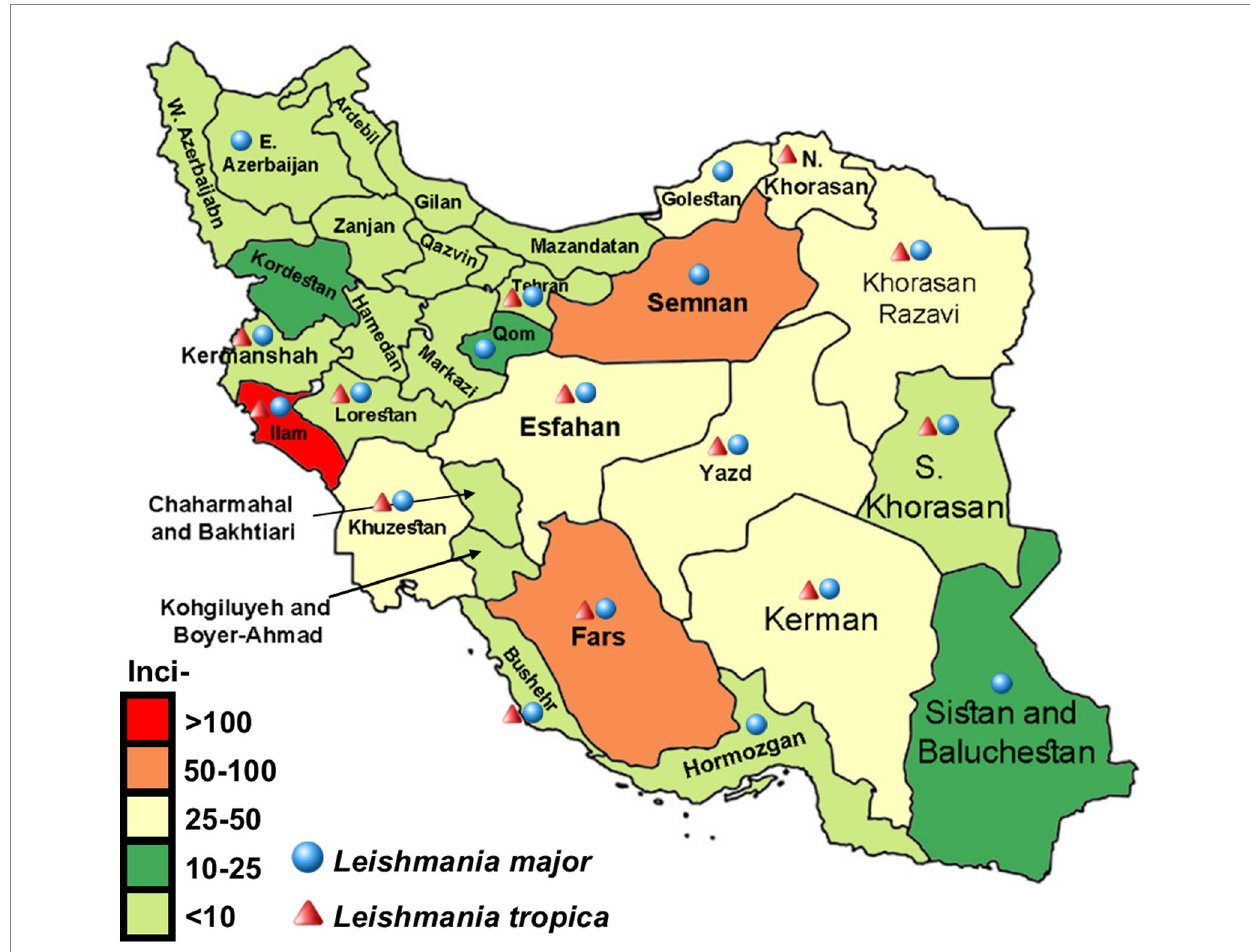
FIGURE 4 Displaying distribution and average incidence rate (2013–2020) of zoonotic cutaneous leishmaniasis and anthroponotic CL caused by Leishmania major and L. tropica, respectively. Infections with both diseases are detected in most provinces of